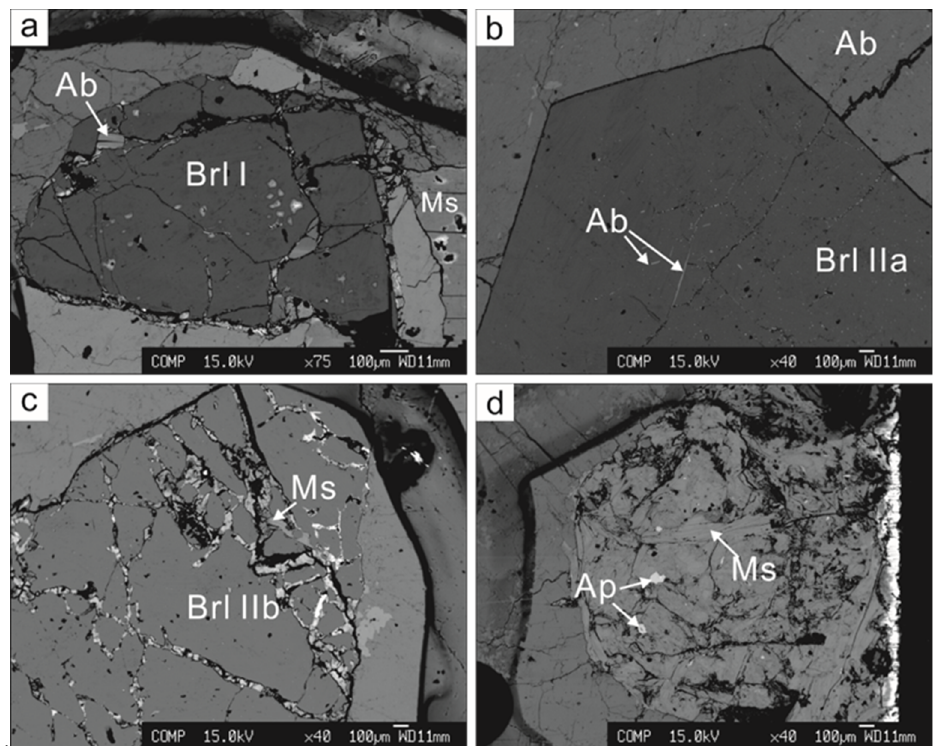
Figure 6. Backscattered electron (BSE) photomicrographs of beryl (Brl) from the Dakalasu No.1 pegmatite ( a ) Beryl I coexists with albite and mica overgrown, and filling the fissures in the beryl I; ( b ) Beryl IIa is closely associated with albite and contains albite crystals inside; ( c ) Beryl IIb fissures are developed, and the fissures are filled with mica and apatite; ( d ) An aggregate composed of mica and a small amount of apatite was found to metasomatized the original minerals near Beryl. Brl I: Derived from coarse-grained Beryl in the wall zone, Brl IIa, and IIb: Derived from prismatic Beryl in the intermediate zone. Abbreviations: Ab = ablite, Ap = apatite, Brl = beryl, and Ms = muscovite.